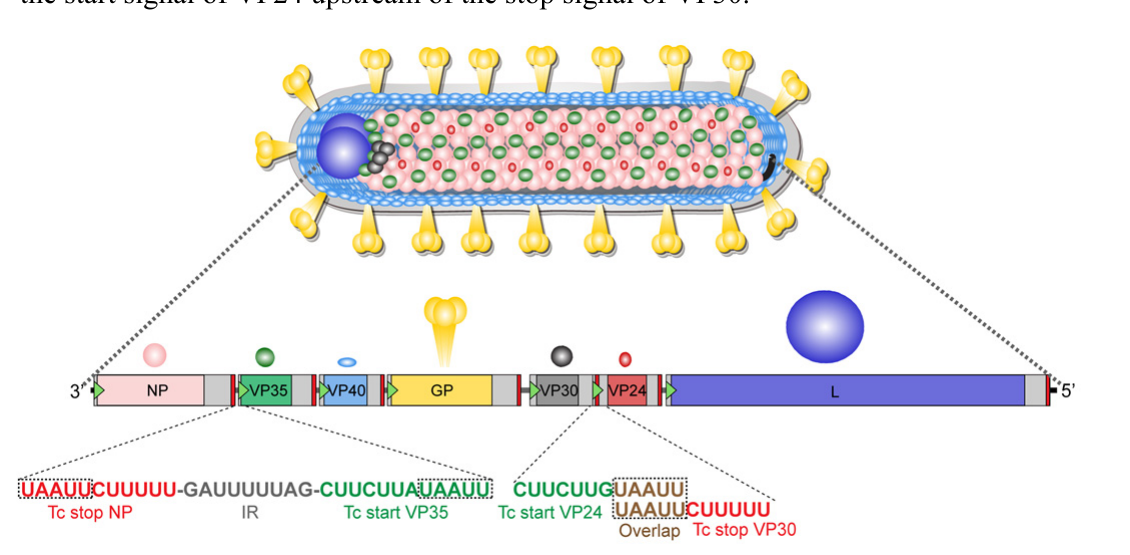
Figure 5. Marburg virion structure and genome organization. Above, schematic of Marburg virion. Below, structure of the MARV genome with transcription signals. The colors of the open reading frames correspond to the colors of the viral proteins. Untranslated regions of the different genes are shown as light grey boxes; intergenic regions (IR) are shown as dark grey lines and the leader and trailer of the genome are colored in black. Transcription start signals (Tc start) are represented by green triangles, while transcription stop signals (Tc stop) are shown as red bars. The sequence of two gene borders (NP/VP35 and VP30/VP24) is shown in 3’ to 5’ orientation, as it occurs in the negative sense RNA genome (MARV Musoke, GenBank accession number: NC_001608). The gene border between VP30 and VP24 contains overlapping transcription signals, with the start signal of VP24 upstream of the stop signal of